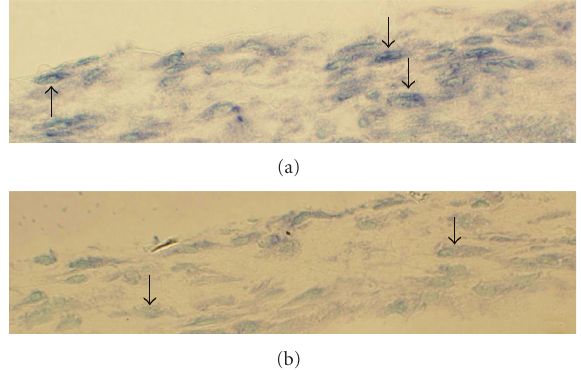
Figure 8: In situ hybridization for the demonstration of TNF- alpha mRNA in fibroblasts. Adjacent sections are shown: antisense staining (a), and sense staining (b). There are reactions in (a) but not in (b). The arrows point at